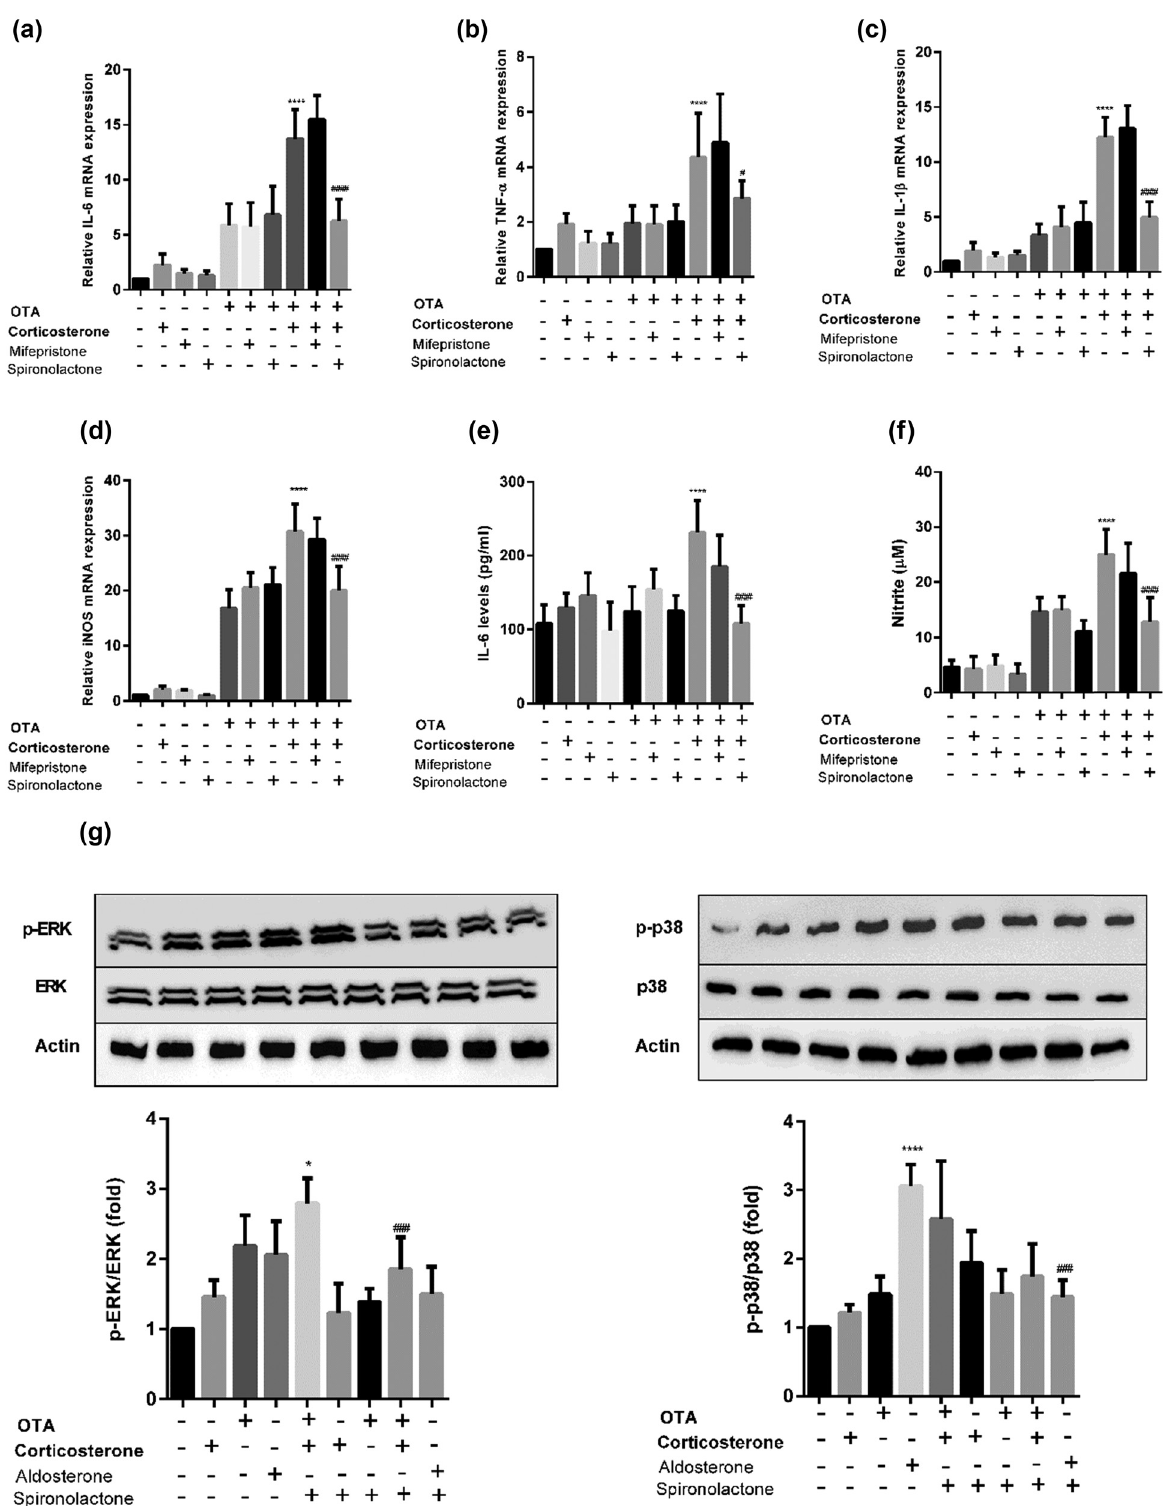
Figure 4: Potentiation e ff ects on OTA - induced cytokine mRNA expression and IL - 6 and NO production in BV - 2 cells. BV - 2 cells were pre - treated with corticosterone ( 25 nM ) in the absence or presence of spironolactone ( 1 μ M ) or mifepristone ( 1 μ M ) for 12 h and then exposed to OTA ( 250 nM ) for 24 h. ( a – d ) mRNA levels of IL - 6, TNF - β , IL - 1 β , and iNOS examined by real - time PCR. ( e ) IL - 6 levels detected by ELISA. ( f ) NO levels measured by Griess reagent. ( g ) Phosphorylation levels of ERK and p38 MAPK determined by western blot analysis. Data were expressed as mean value ± SD of at least three independent experiments. * p < 0.05 and **** p < 0.0001 compared with OTA; # p < 0.05 and #### p < 0.0001 compared with OTA and